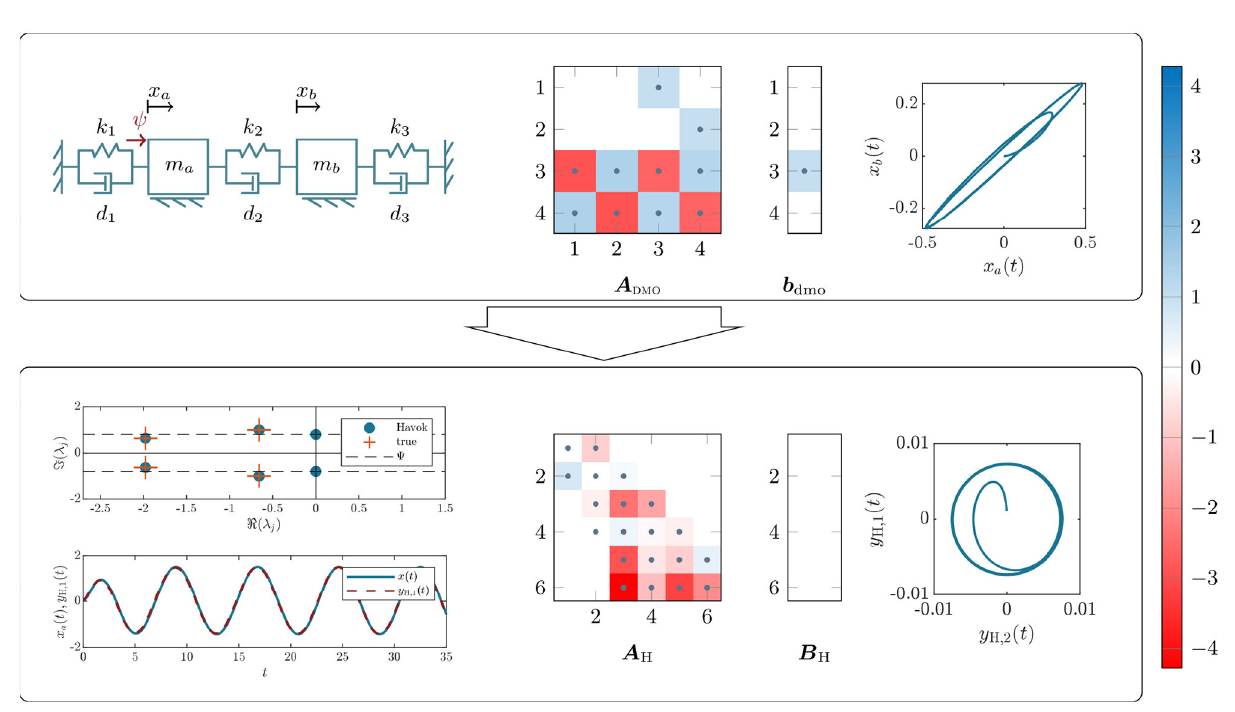
FIGURE5 The HAVOK model (bottom) for a double mass oscillator compared to its analytical basis (top). The state matrix A and input matrices B are shown in color code where red, white, and blue squares denote negative, zero, and positive entries of the matrices, respectively. To ensure that small values don’t get lost in the color scale, all non-zero entries are marked with gray dots additionally. The eigenvalues of the two systems match. State-space representations and the time series comparisons show that the reduced-order model reproduces the dynamics of the original system well, except for a difference in amplitude, which is visible in the state space plots. For better visualization, the time series data of both x a ( t ) and y H,1 ( t ) is normalized to have zero mean and a standard derivation of